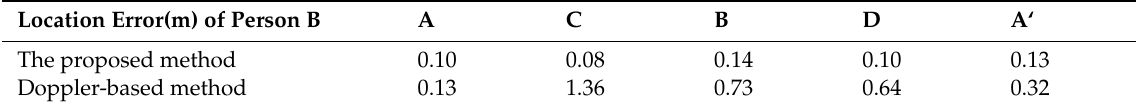
Table 5. Comparison of location errors of Person A.